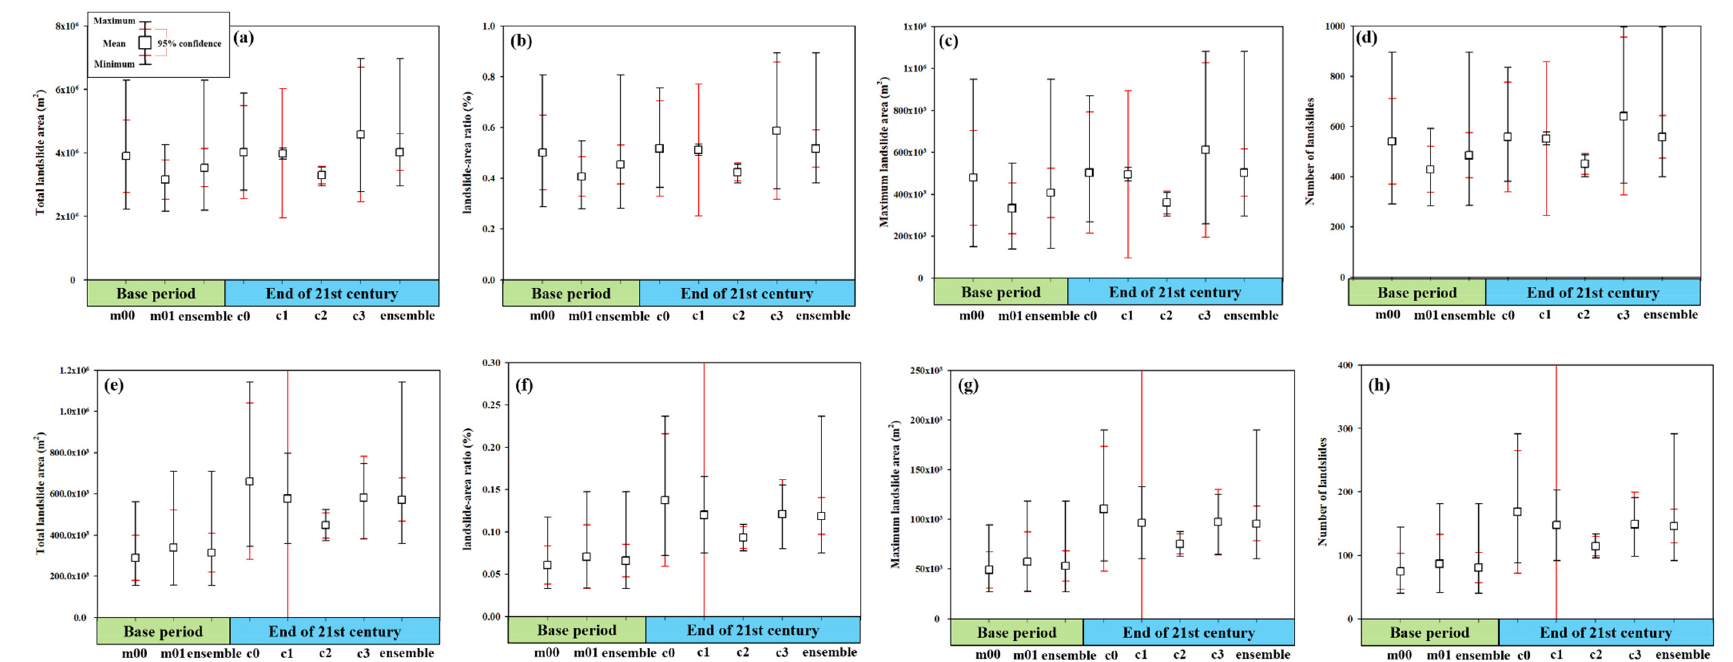
Figure 3. Statistics of landslide-area characteristics for the top 10% typhoons of each scenario and ensemble during the base period and the end of the 21st century. ( a – d ) are for the Shihmen Reservoir catchment and ( e – h ) are for the Xindian River